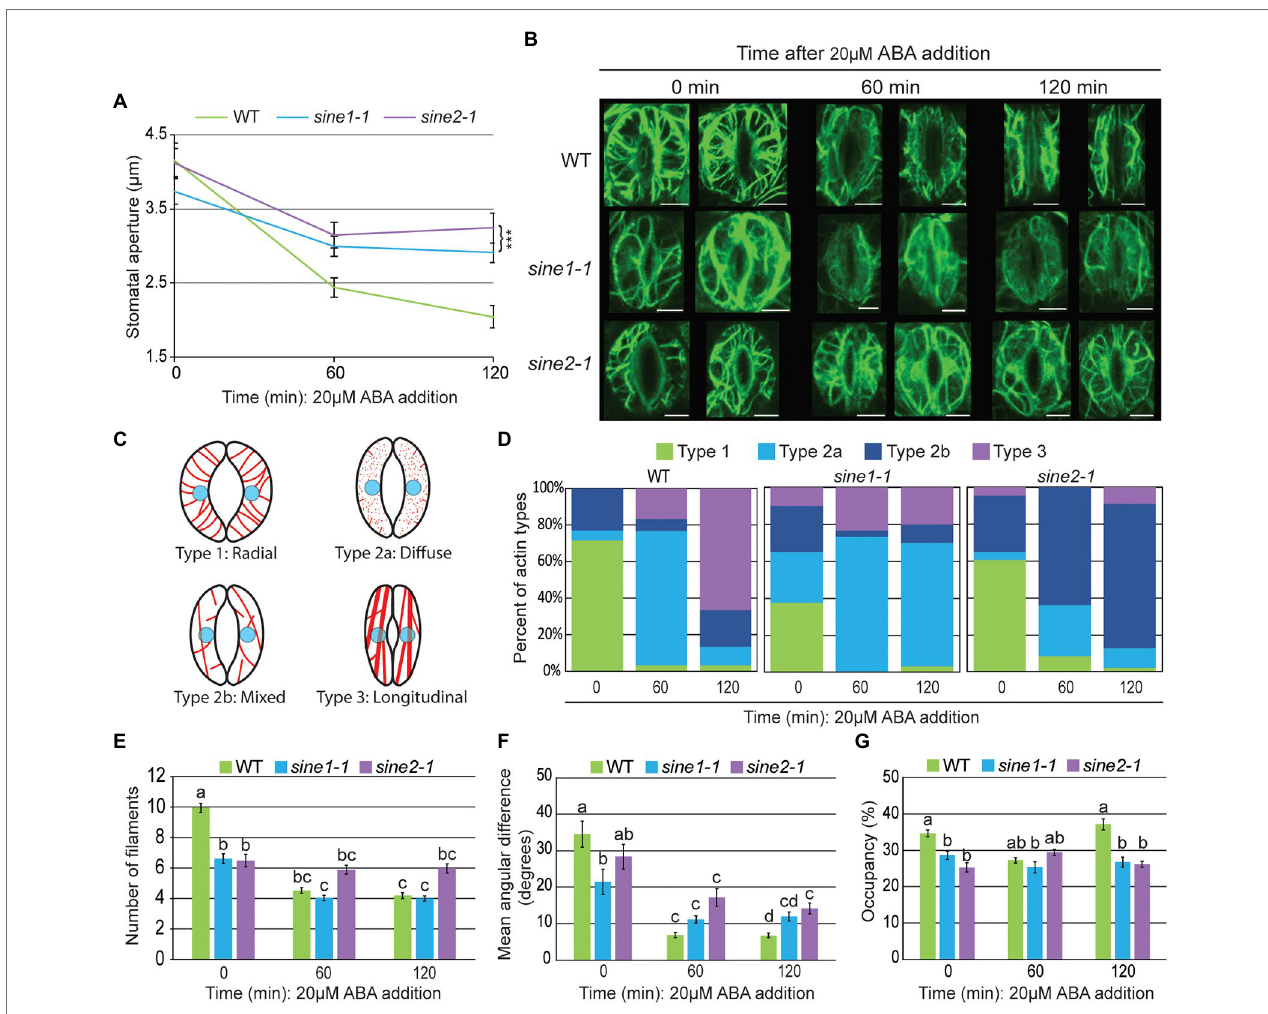
FIGURE 1 | Actin re-organization is disrupted in sine1-1 and sine2-1 during ABA-induced stomatal closure. (A) Stomatal aperture measurements at 0, 60, and 120 min after ABA addition in GFP-LIFEACT transgenic lines. Data are mean values ± SE from three independent experiments. N ≥ 30 stomata. Symbols denote statistically significant difference from WT as determined by Student’s t -test, with *** p < 0.001. (B) Representative maximal intensity projections of GFP-LIFEACT in the guard cell cortex at 0, 60, and 120 min after ABA addition. Scale bars = 5 μ m. (C) Schematic representation of the different actin organization types defined here for quantification in (D) . (D) Distribution of actin types at 0, 60, and 120 min after ABA addition. N ≥ 30 guard cells. For description of types, see text. (E) Number of actin filaments. (F) The mean angular difference of actin filaments. (G) Occupancy (density) of actin filaments. (E–G) Data are mean values ± SE from three independent experiments ( N ≥ 30 guard cells). Statistical significance was calculated using one-way ANOVA followed by a post-hoc Tukey HSD test. Lowercase letters denote groups that are statistically different ( p <